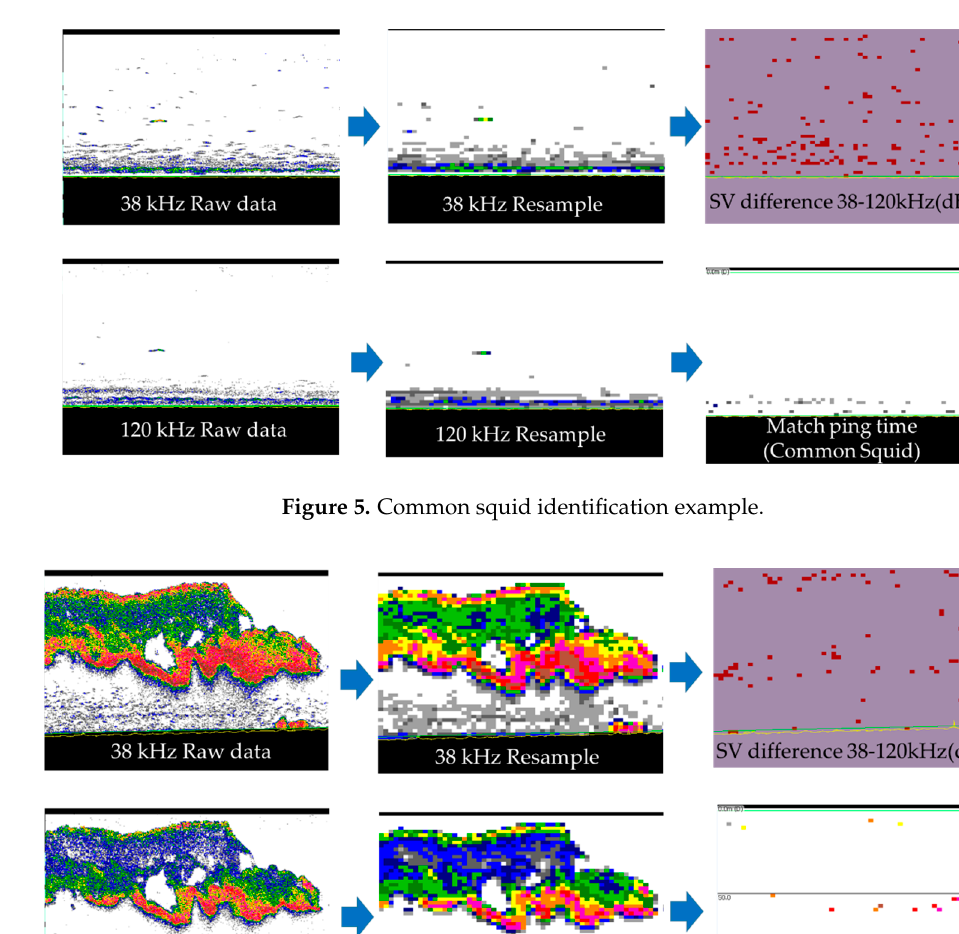
Figure 4. Anchovy identification example.